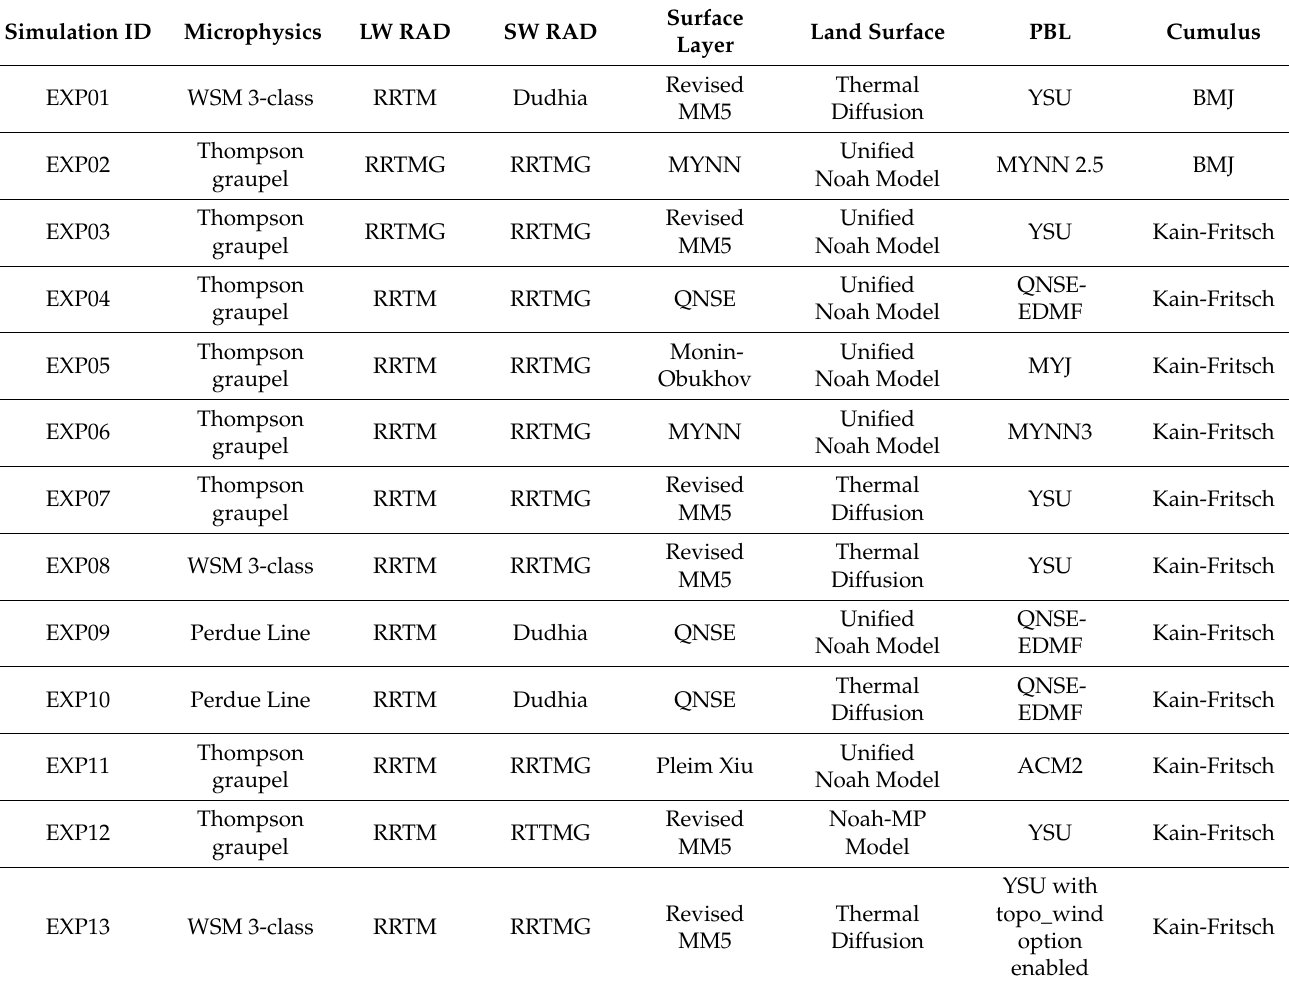
Table 3. Physical scheme options used for the different 13 WRF